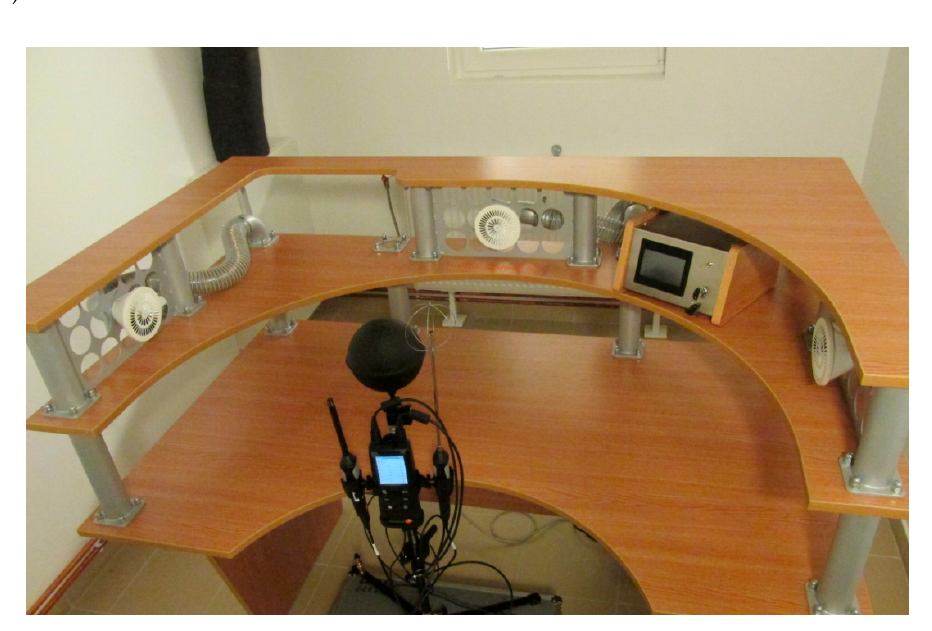
Figure 1. ALTAIR PV equipment.